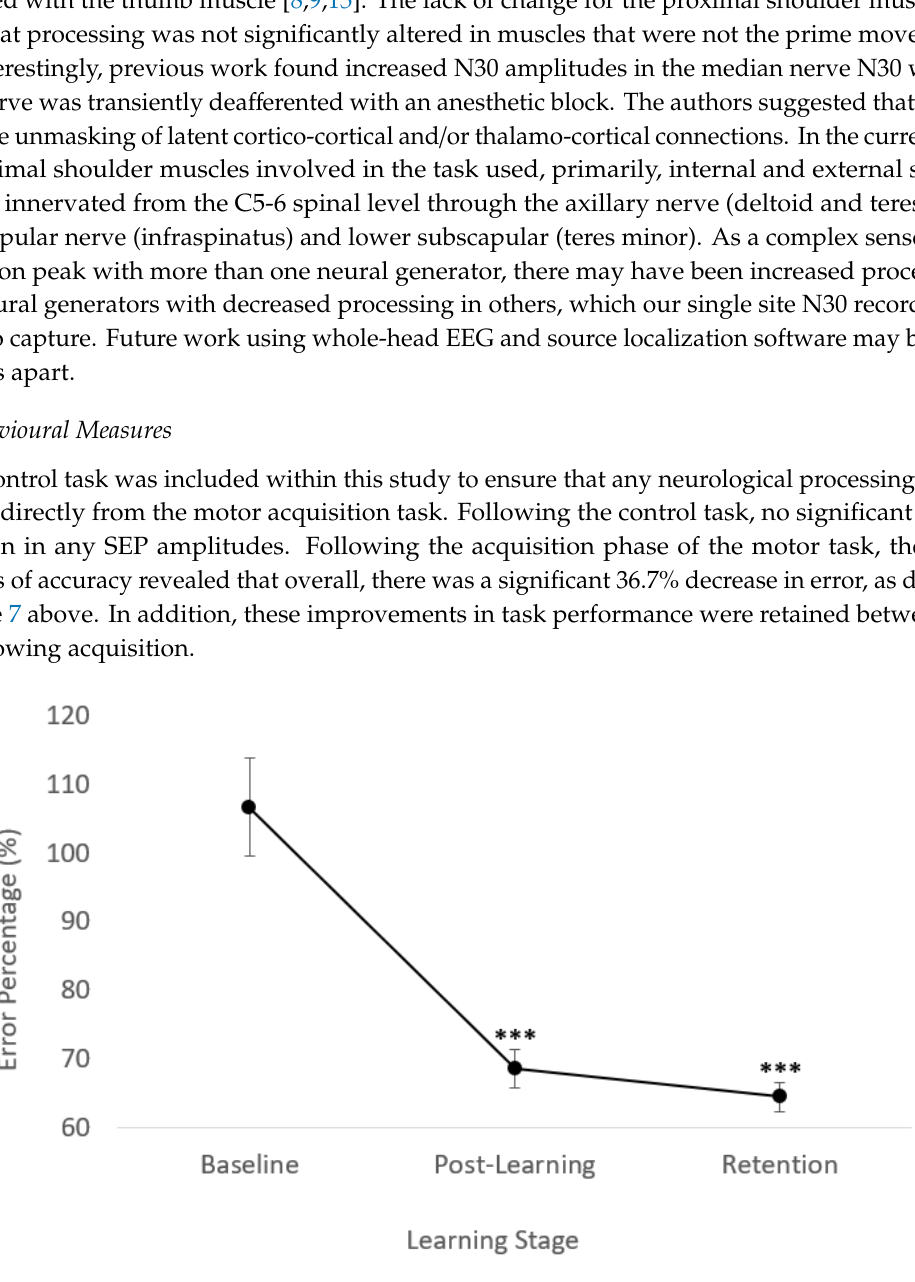
Figure 7. Improvements in tracing accuracy ± SE. ***= p < 0.0001 relative to baseline.